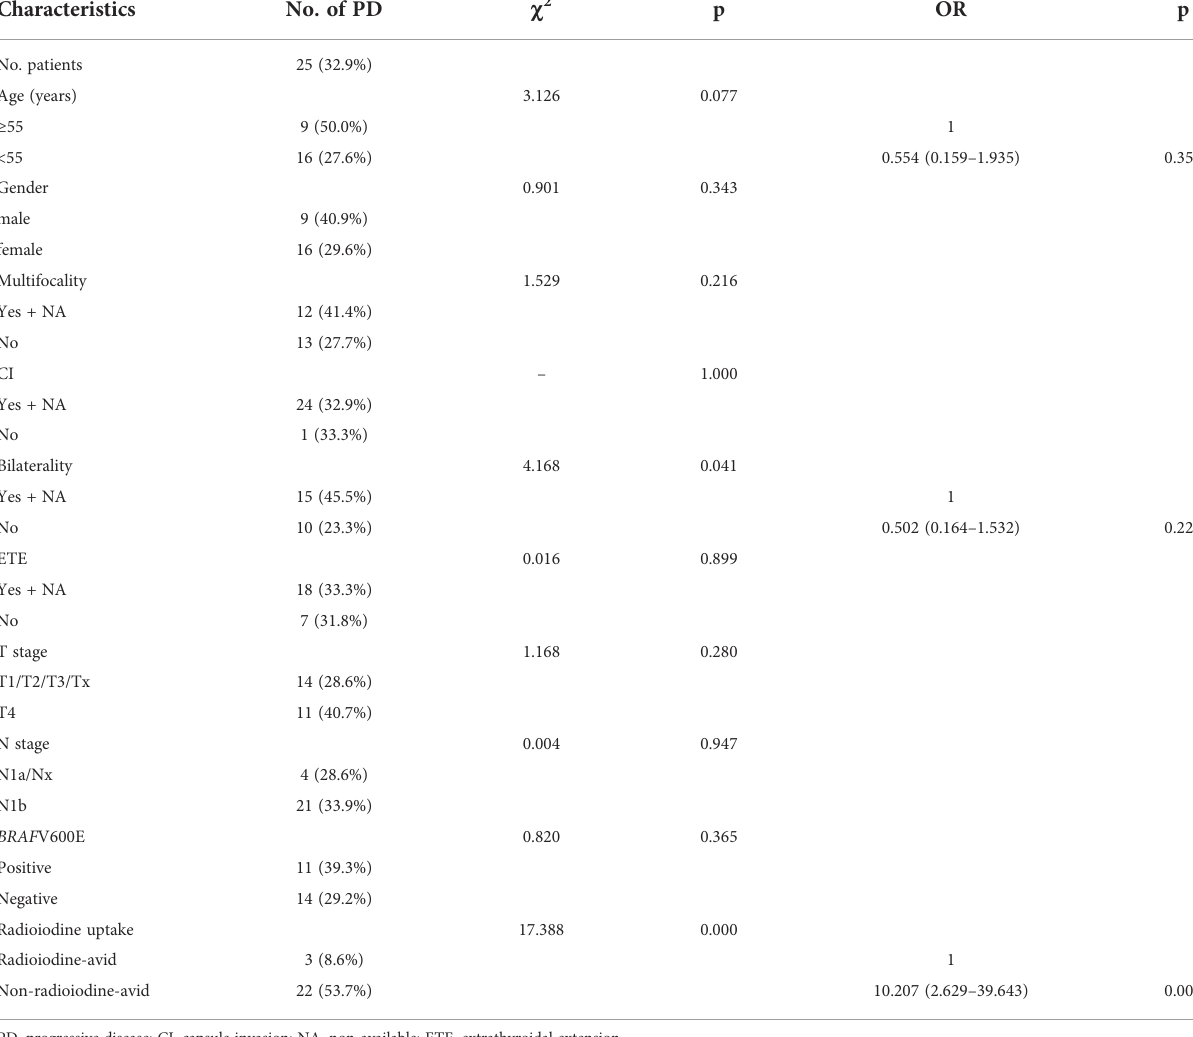
TABLE 4 Univariate and multivariate analyses of predictors of progressive disease in 76 patients.